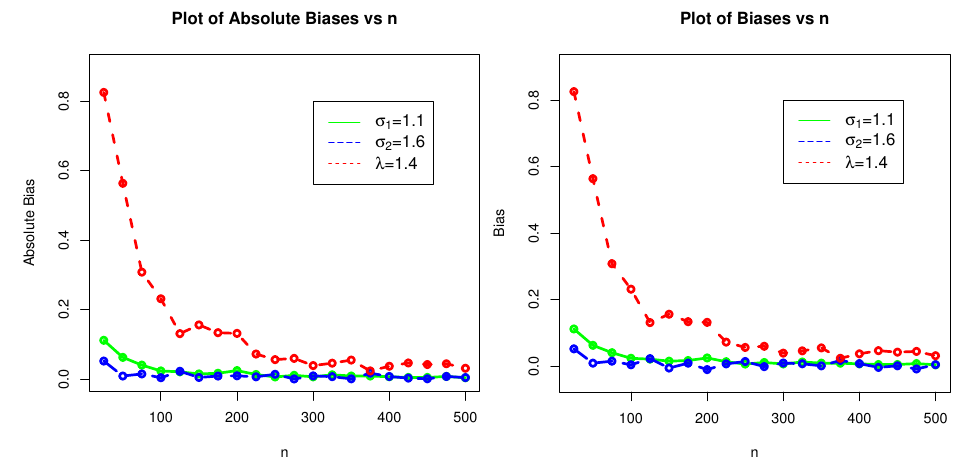
Figure 3. A visual display of the results of the SimS of the NMFWE model for σ 1 = 1.1, σ 2 = 1.6, and λ = 1.4.